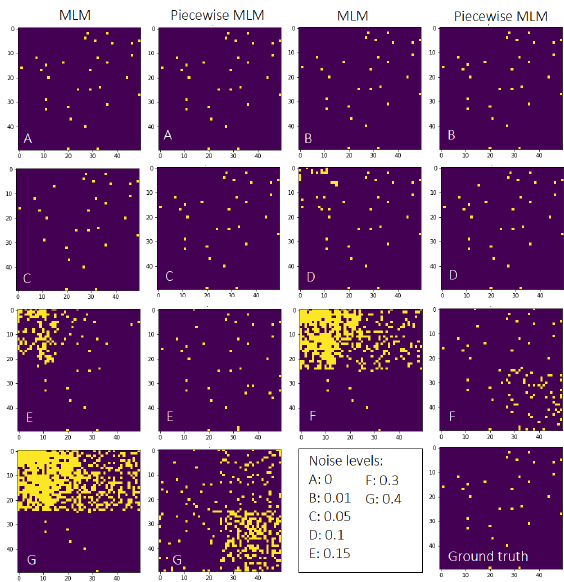
Figure 8: The ColorChecker dataset, the pairwise comparison of the MLM anomaly detection maps (on the left) and the piecewise MLM (on the right) with different amount of noise in the data. The level of the noise is marked with the alphabets.